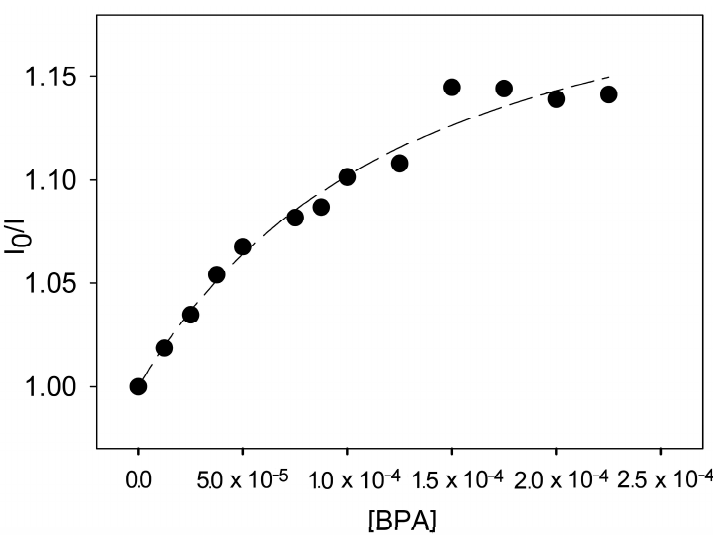
spectra of [Ru(phen) 2 L ] 2+ .